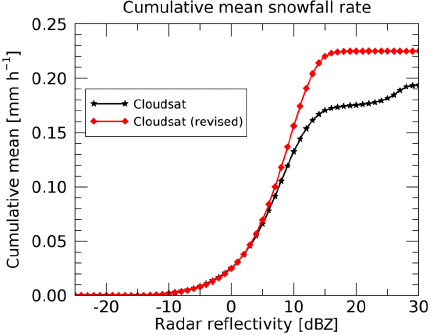
Figure 6. Impact of surface topography issues on cumulative snow- fall